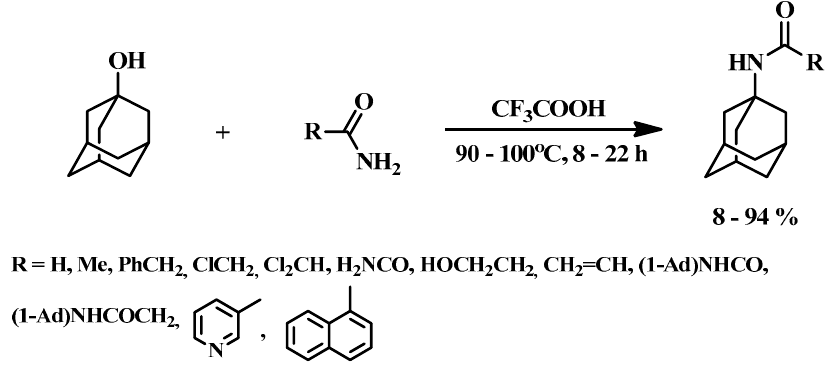
Figure 2. Adamantylation of amides in trifluoroacetic acid.